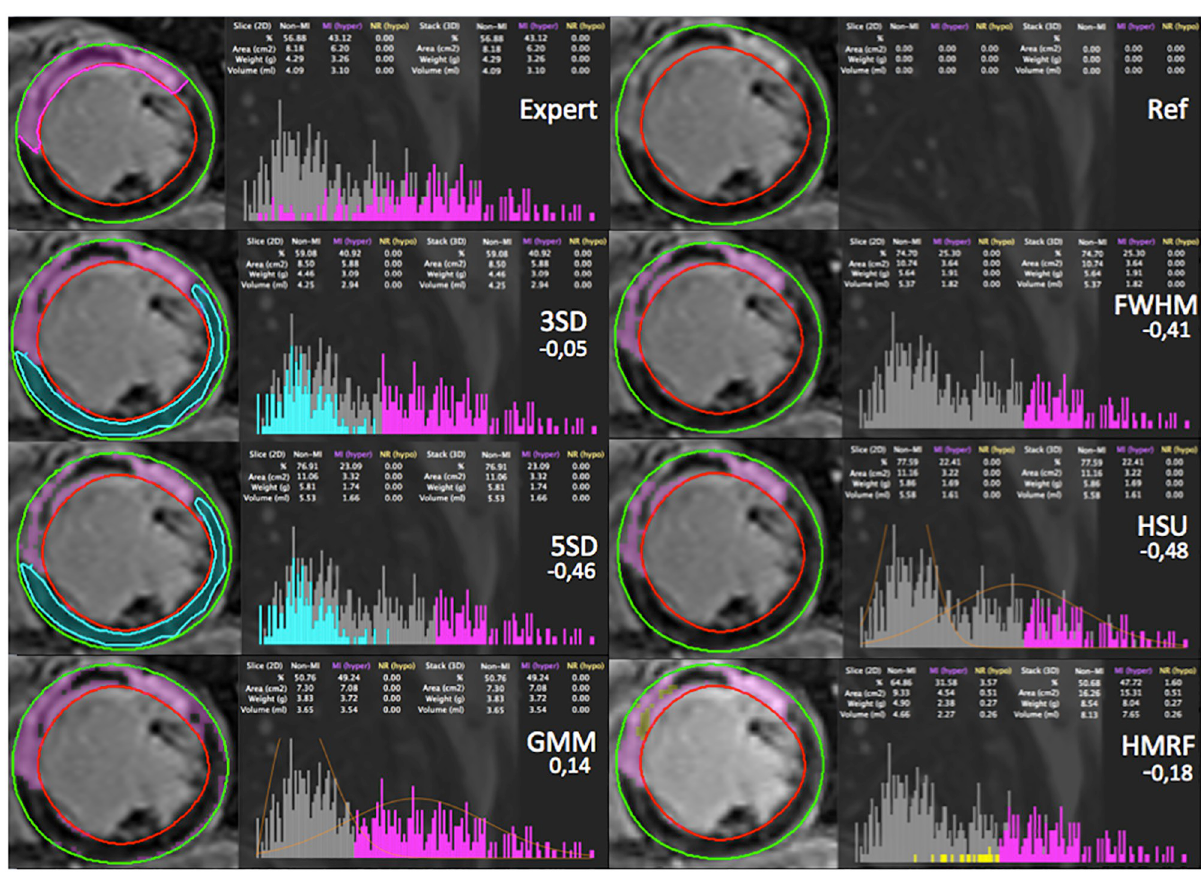
Fig 7. Comparison between the manual segmentation made by an expert (without the definition of the MVO region), and the segmentation made by each of the methods within CMRSegTools. For each segmentation, the figure shows: epicardium (green) and endocardium (red) contours from the myocardial segmentation, lesion segmentation (magenta), remote healthy myocardium (turquoise), no-reflow region by HMRF (yellow), histogram, quantification statistics and relative error.